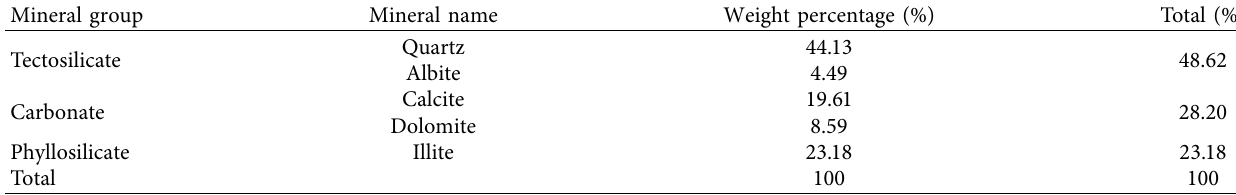
Table 1: Detailed mineralogical compositions (wt%) of Longmaxi sample before